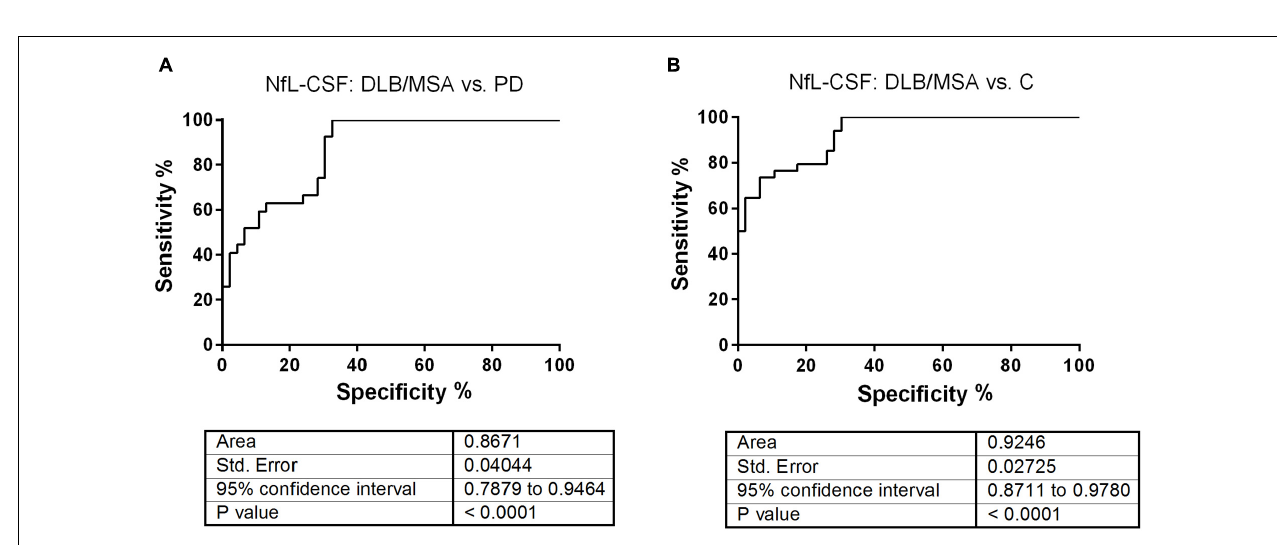
FIGURE 2 | Receiver operating characteristic (ROC) curve analysis of CSF-NfL levels. To increase the statistical power, we combined DLB and MSA in one group considered as other synucleinopathies. (A) The diagnostic accuracy of CSF-NfL was assessed with ROC-derived area under the curve (AUC) values (with 95% CI) for the discrimination of patients with other alpha-synucleinopathies from PD. The AUC values of 0.87 ± 0.04 SD, 95% CI of 0.79–0.95 indicated a very good diagnostic accuracy. (B) The diagnostic accuracy of CSF-NfL was assessed for the discrimination of patients with other alpha-synucleinopathies from controls (indicated as C). The AUC values of 0.92 ± 0.03 SD, 95% CI of 0.87–0.98 indicated a very good diagnostic accuracy.